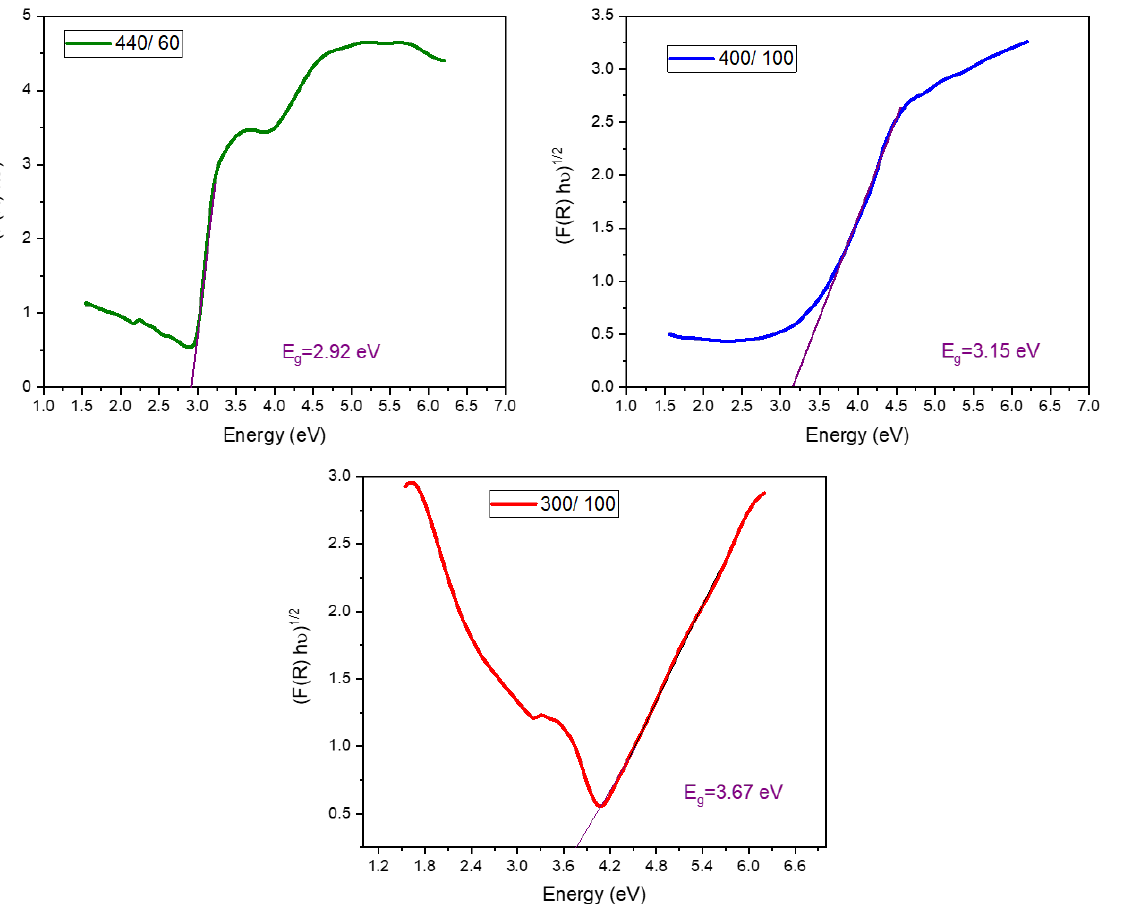
Figure 8. Tauc diagrams to calculate the Eg of the rings with argon-oxygen flow sccm 440 – 60, 400 – 100 and 300 – 100.